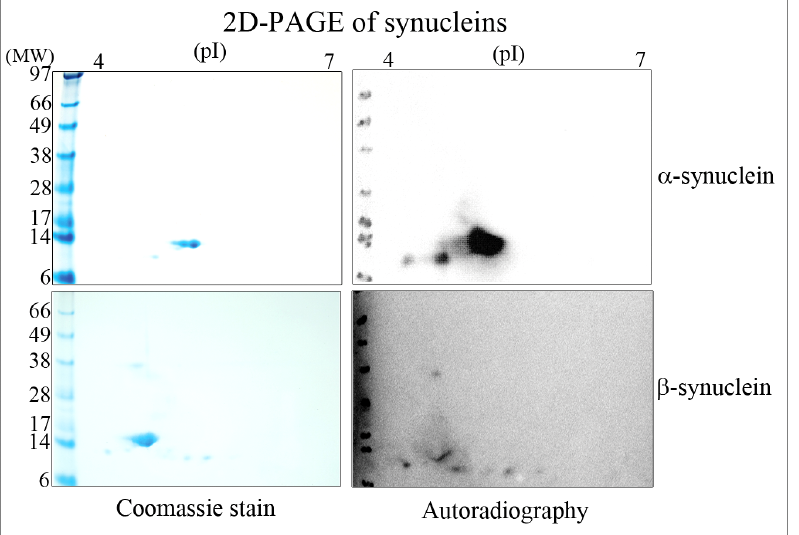
Figure 4. 2D-PAGE of invitro aged synucleins. Five m g of 20 day in vitro aged a -synuclein (upper panels) or 5 m g of 20 day in vitro aged b - synuclein (lower panels) were methylated with 3 H-SAM using exogenous PIMT, and proteins resolved by 2D-PAGE. Proteins were stained with Coomassie (left panels), and methylation of isoaspartate visualised by autoradiography (right panels).